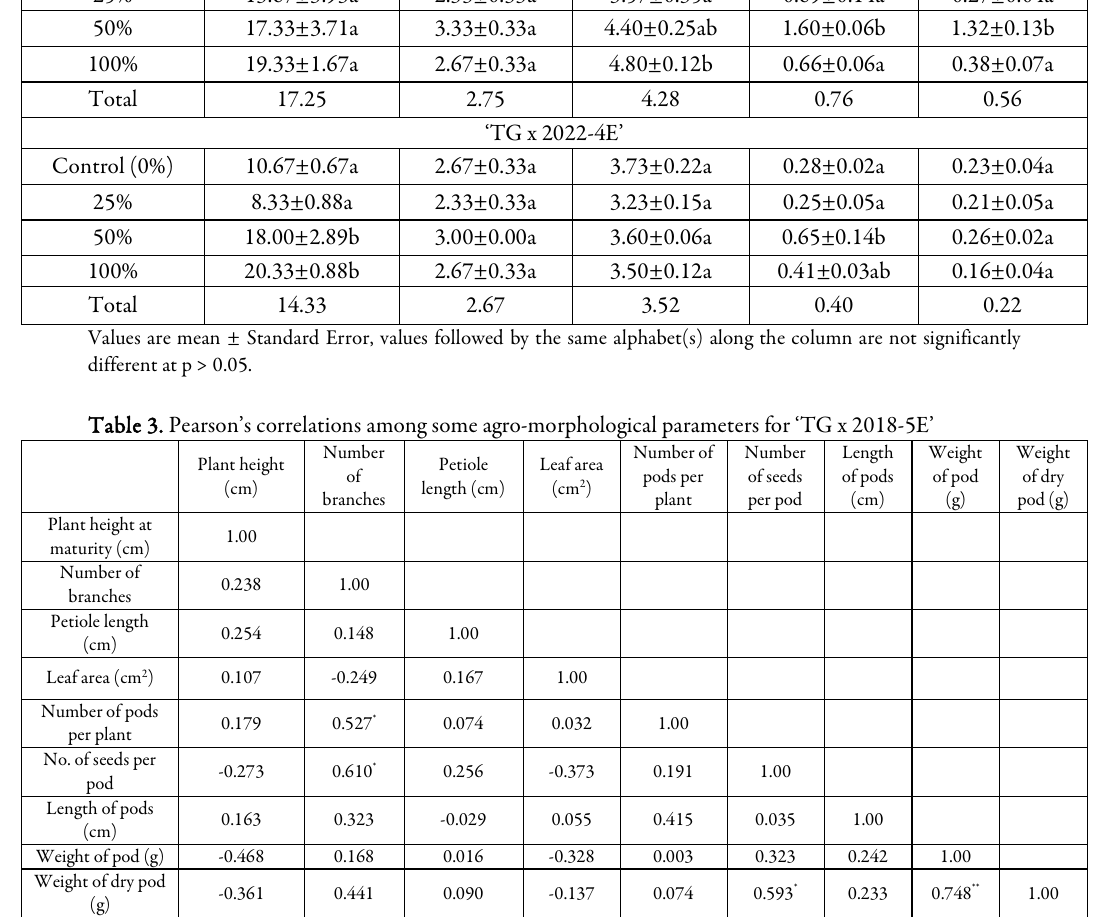
Table 2. Effects of Datura aqueous seed extracts on yield attributes of soybean varieties Number of pods Number of Length of pods Weight of fresh Weight of dry Treatments per plant seeds per pod (cm) pod (g) pod (g) ‘TG x 2018-5E’ Control (0%) 18.67±4.81a 2.67±0.33a